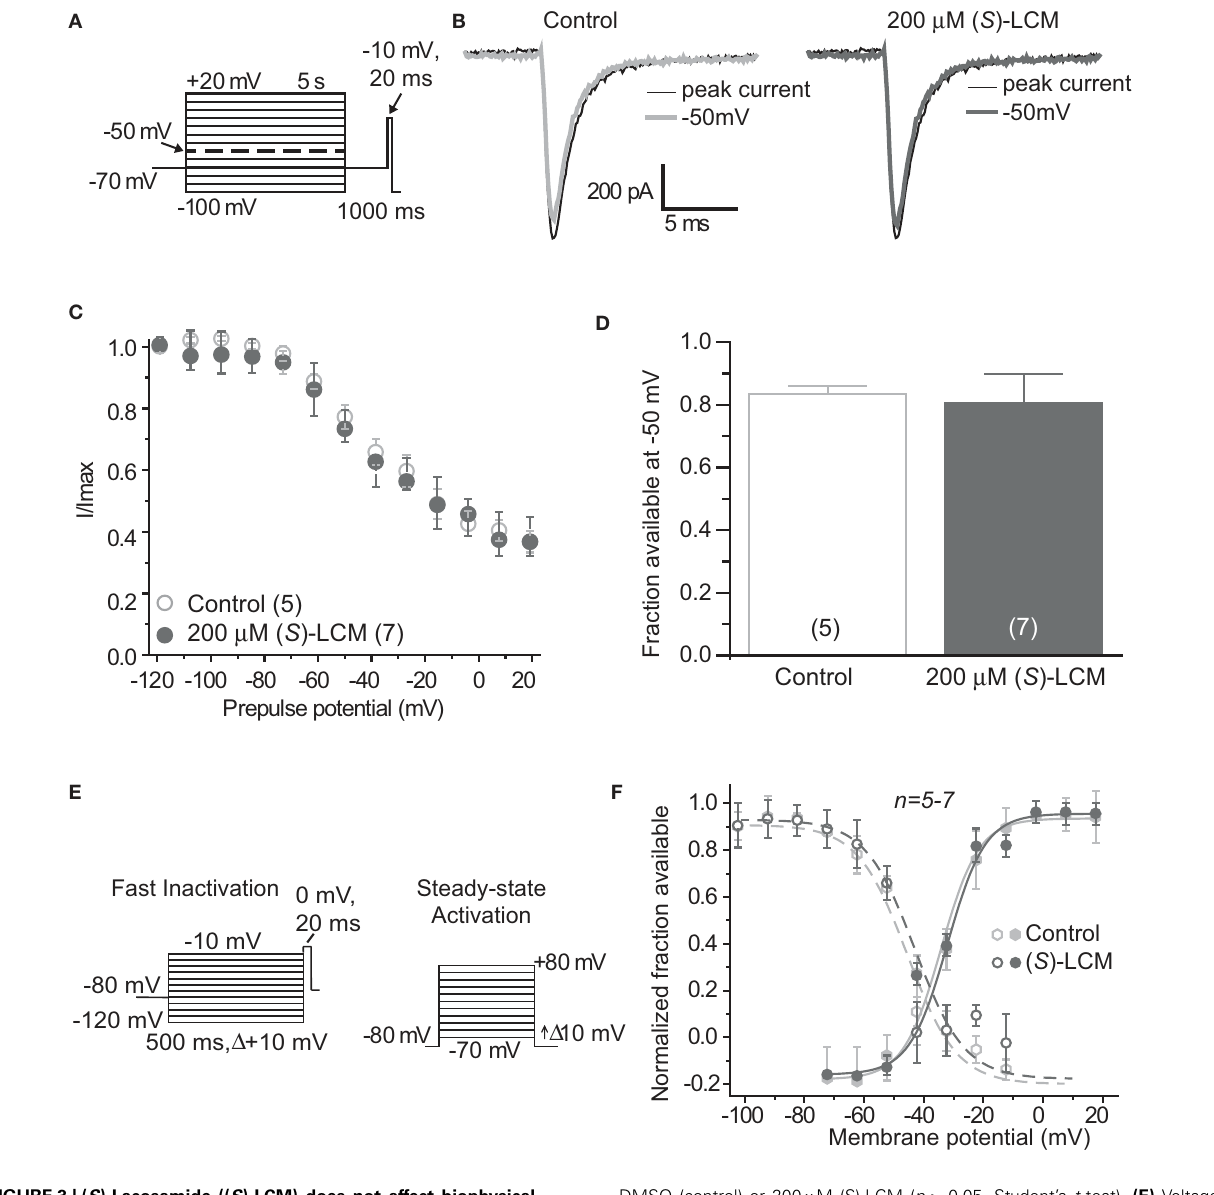
FIGURE 3 | ( S )-Lacosamide (( S )-LCM) does not affect biophysical properties of voltage-gated sodium currents in cortical neurons. (A) Voltage protocol for slow inactivation. (B) Representative current traces from cortical neurons in the absence (control, 0.1% DMSO) or presence of 200 μ M (S)-LCM. The thin black and thick gray traces represent the currents evoked at − 100 and − 50mV, respectively (also highlighted in the voltage protocol as a dashed thick line). (C) Summary of steady-state slow activation curves for neurons treated with DMSO (control) or 200 μ M (S)-LCM. No drug-induced slow inactivation was evident at voltages more depolarizing that − 80mV in neurons treated with ( S )-LCM. (D)